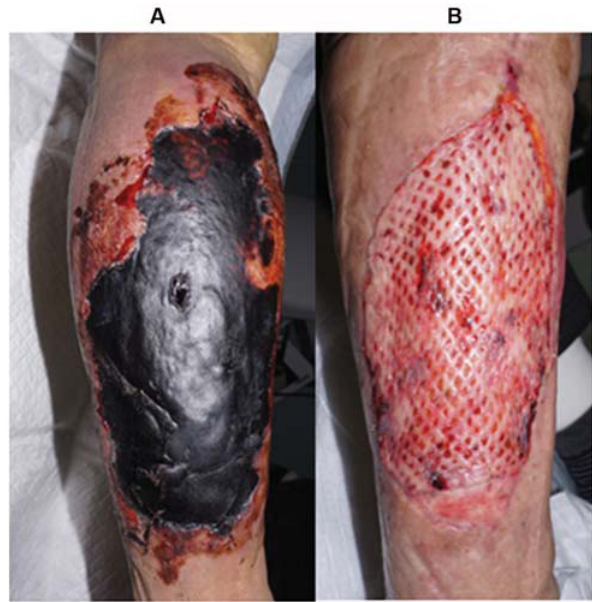
Fig. 2 ( A ) Necrotized and blackened skin of the right calf on Day